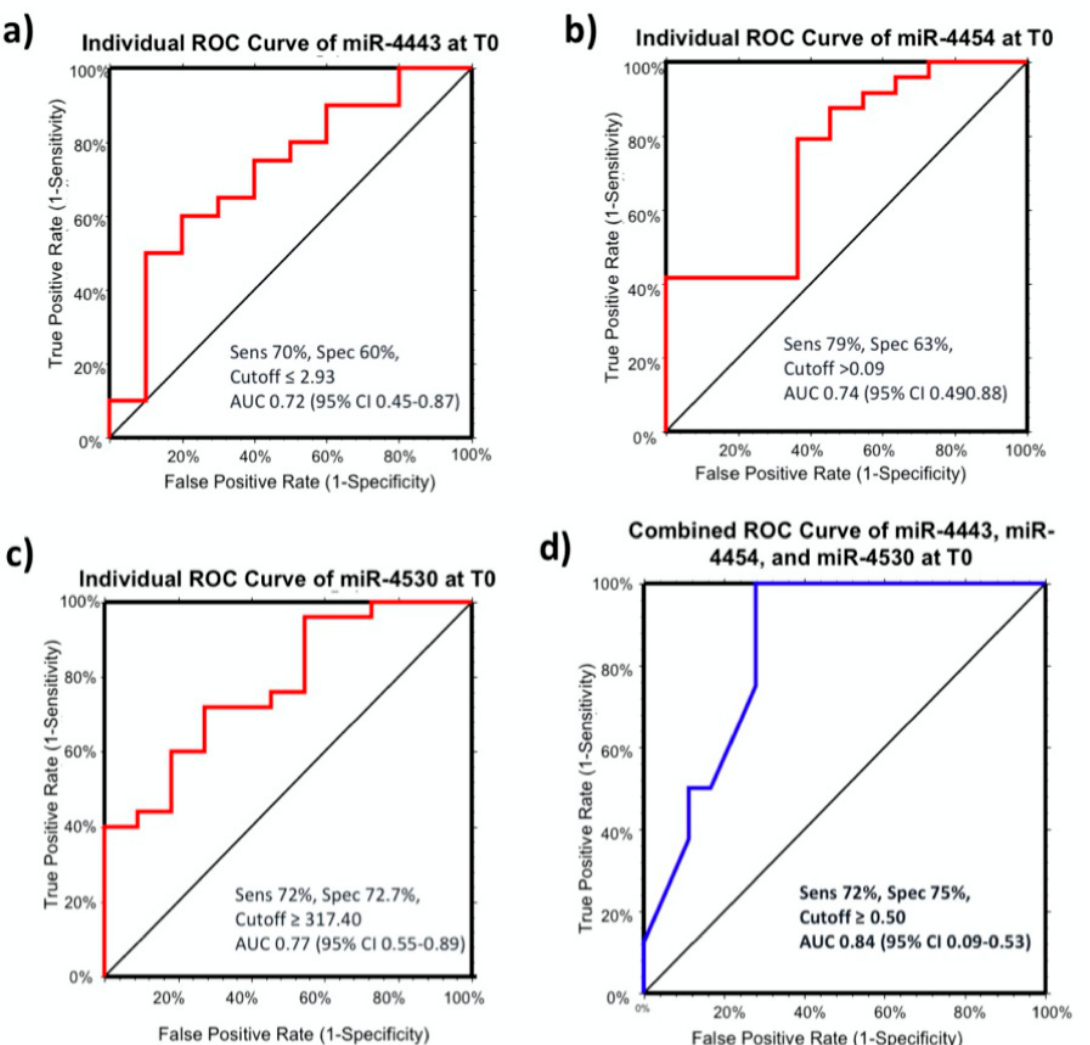
Figure 3. Receiver operating curve (ROC) analysis of miR-4443 ( a ), miR-4454 ( b ), miR-4530 ( c ), and a combination of the three miRNAs ( d ). The combination of the three miRNAs could determine the accuracy on distinguishing CR from PRPD before curative therapy (T0) with an AUC of 0.84 (95% CI 0.45–0.87) using an optimal cut-o ff value of 0.50, which demonstrated a sensitivity of 72% and a specificity of 75%. CR = complete responder, PRPD = partial responder and progressive